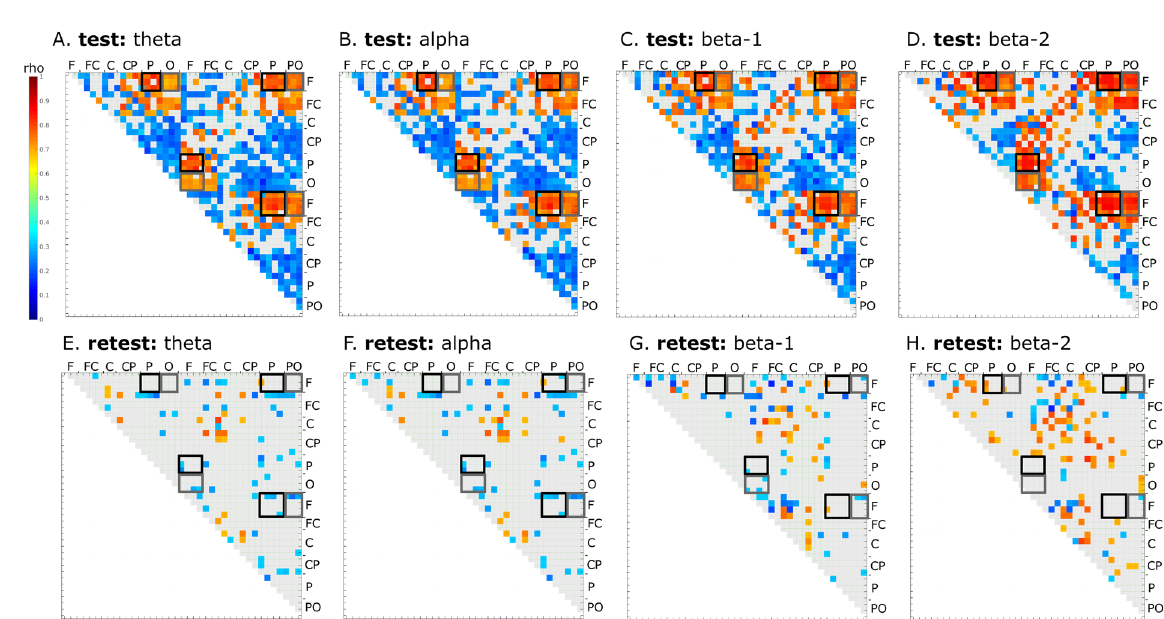
Figure 3. Significant correlations between gB2rest and PLVs in the visual search task (n = 33) calculated for the expectation window in test ( A–D ) and retest ( E–H ) sessions in different frequency bands. Shades of red and blue denote significant correlation strength (color bar to the left) between the two electrodes indicated next to the box outlines. Light gray squares denote lack of significance. Gray outlines denote PLVs between signals from frontal and occipital electrode sites; black outlines denote PLVs between frontal and parietal sites. All correlations significant at p < 0.05 (FDR